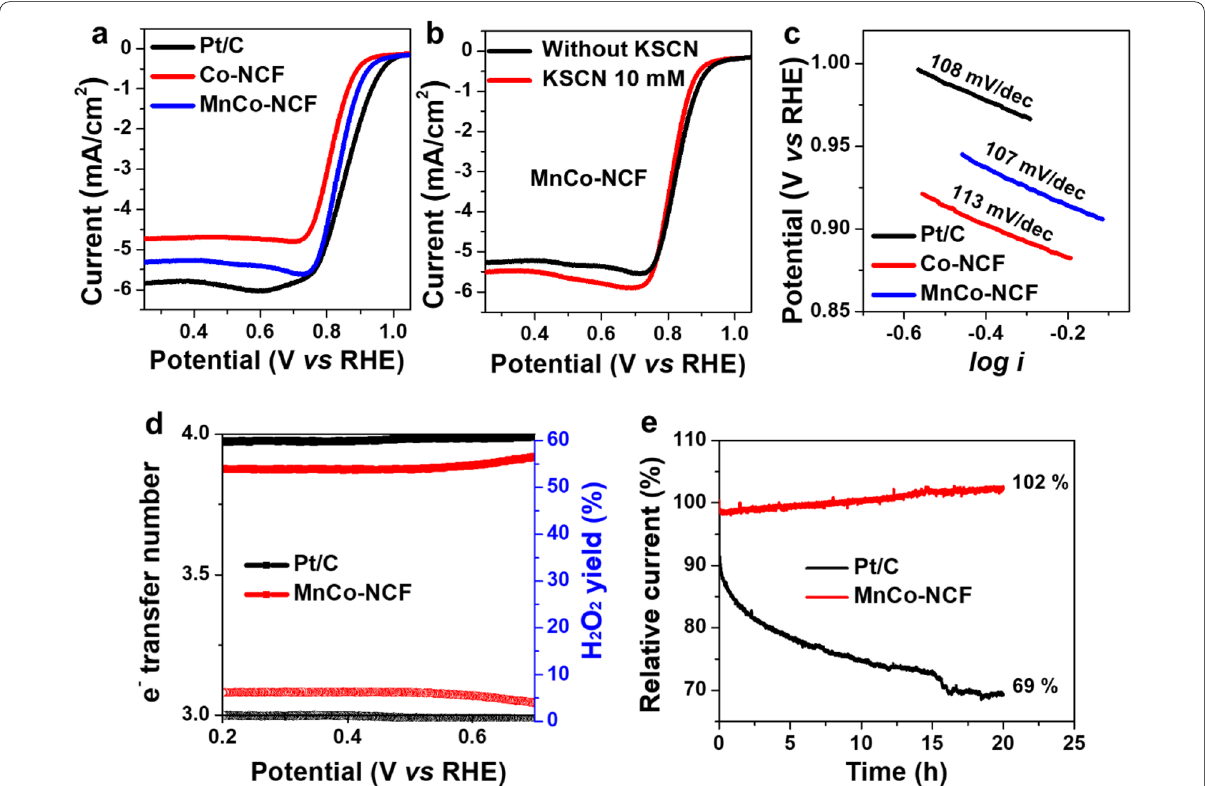
Fig. 4 Electrocatalytic activities of MnCo‑NCF for ORR. a LSV curves of Co‑NCF, MnCo‑NCF, and Pt/C for ORR in O 2 ‑saturated 0.1 M KOH solution at 1600 rpm. b LSV curves of MnCo‑NCF in the presence and absence of KSCN (10 mM), c Tafel plots, and d Electron transfer numbers and peroxide yields of MnCo‑NCF and Pt/C for ORR. e Chronoamperometric responses of MnCo‑NCF and Pt/C for continuous ORR at 0.6 V (vs